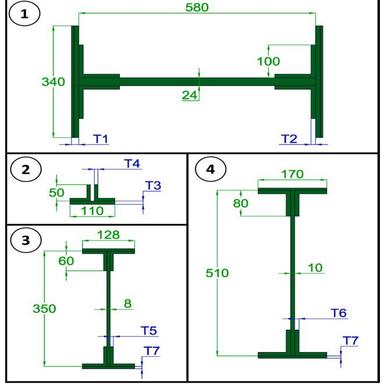
Cross-section of steel members.